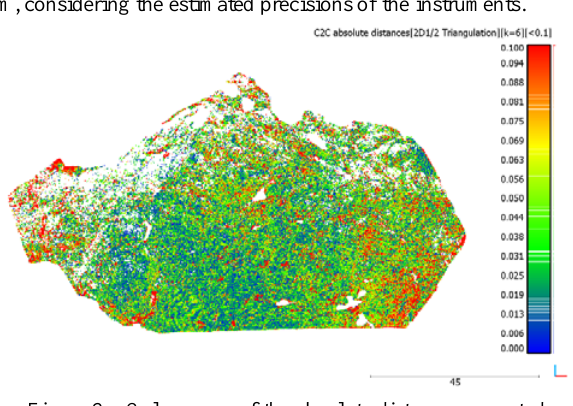
Figure 2 – Colour map of the absolute distance computed between the TLS and the photogrammetric reference model.